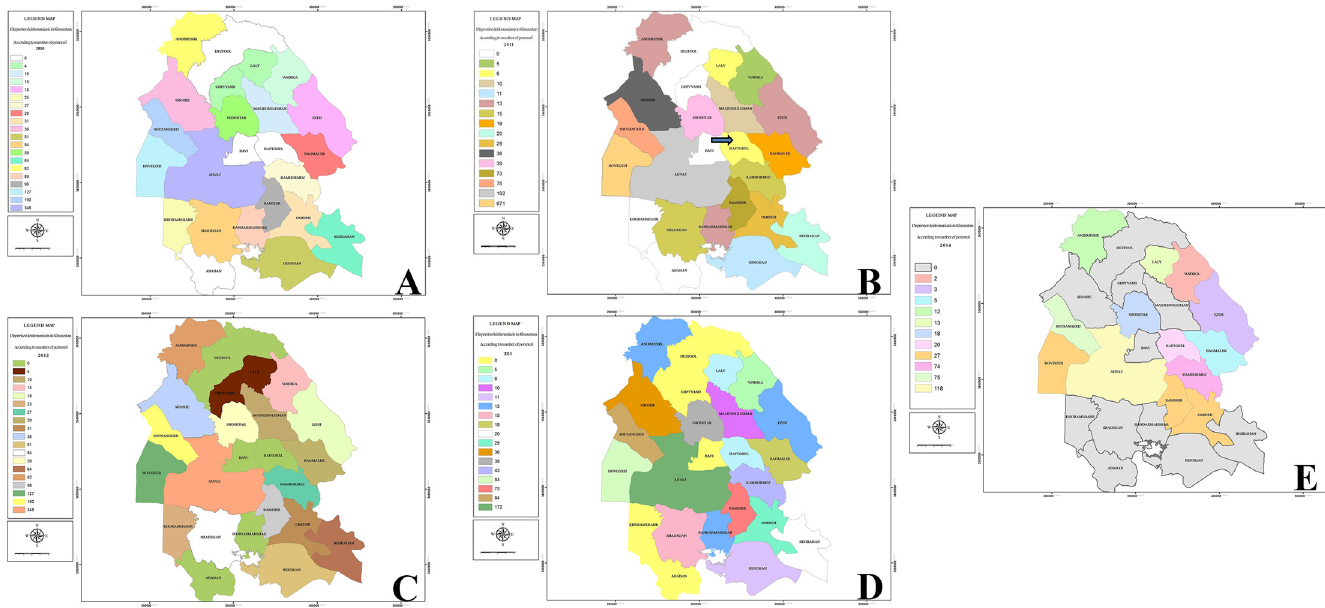
Fig 1. (A) Incidence of cutaneous leishmaniasis (CL) using geographical information system in (GIS) 2010, (B) GIS showed a new focus of CL in 2011 compared to 2010 (arrow), (C) The highest incidence of CLin 2012 with 1363 patients of CL has shown in Khuzestan Province with GIS mapping, (D) Geographical distribution mapping of CL incidence in 2013, E: The incidence rate of CL was diminished after control programs. Ten distinct had no reported of the disease in